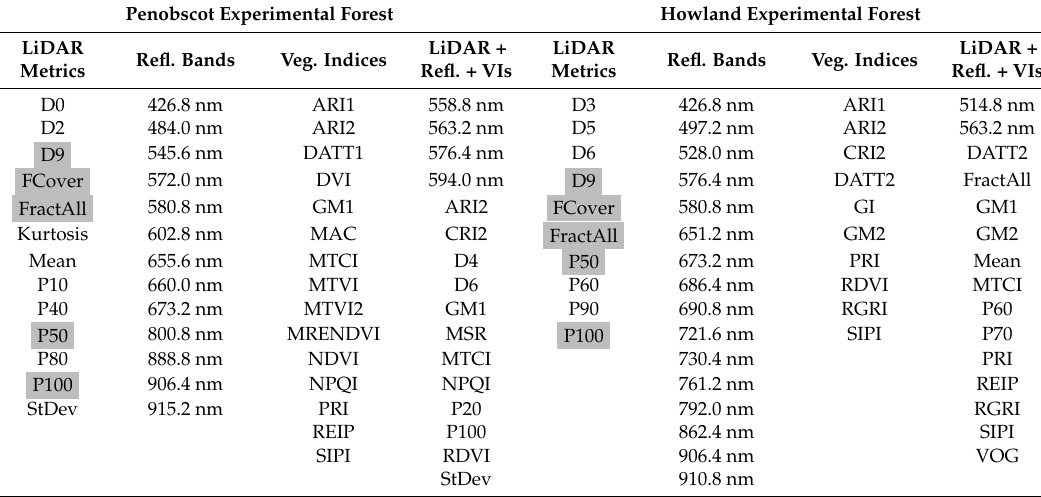
Table 4. Simplified lists of machine learning inputs. Variables used in nodes within the first five levels of classification trees constructed on the full dataset were added to simplified lists serving as inputs for further machine learning analyses. Metrics used to construct the common list of LiDAR metrics are highlighted in gray to indicate shared status across